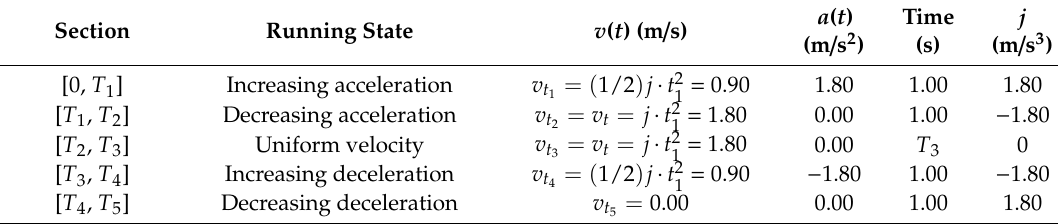
Table 2. The detail data of the simulation results in S-shaped velocity curve.